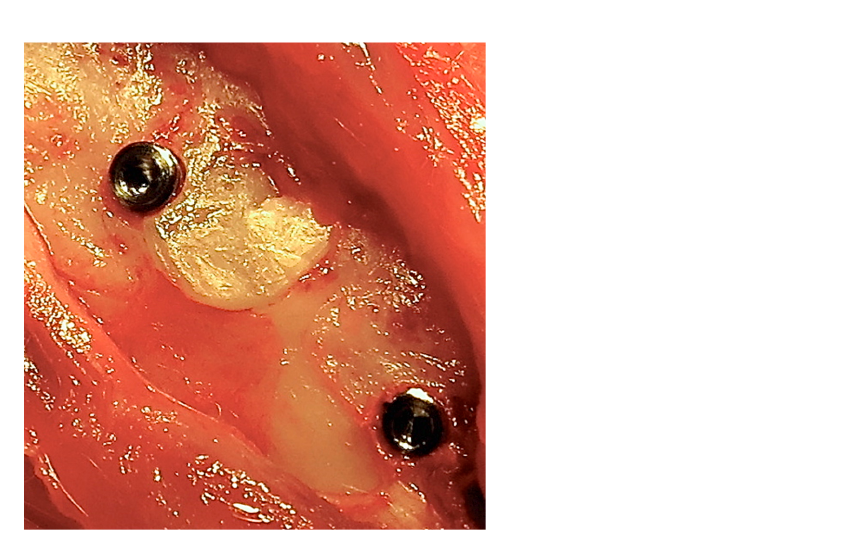
Figure 1. Micro-implants placed at the grafted sites. Top, dentin granulae; bottom, dentin block.